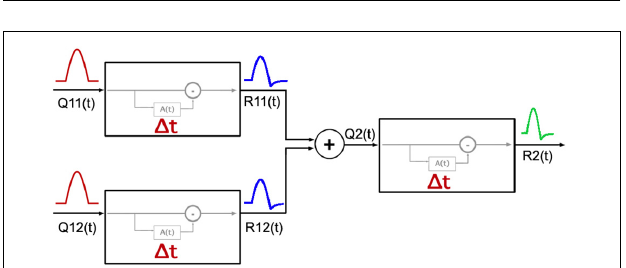
FIGURE 6 | Diagram of the model adopted for the response of the visual system to cardinal and non-cardinal stimulation with a time varying paradigm. The first two units on the left represent two types of RGCs, each with a cumulative function A(t) as modeled by Zaidi et al. (2012) with its own (cid:49) parameter setting the timing properties of adaptation in each visual pathway. Responses from the first stage [R 11 (t) and R 12 (t)] are pooled, and then used as the input [Q 2 (t)] for the second stage